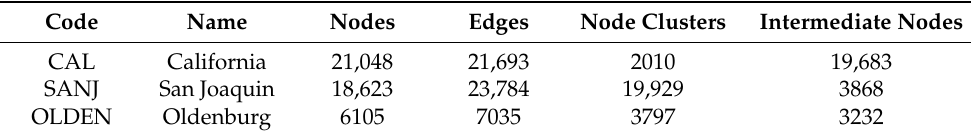
Table 4. Real-world roadmaps indicating attributes like nodes and edges. Node clusters and intermediate nodes are used later in the discussion section.